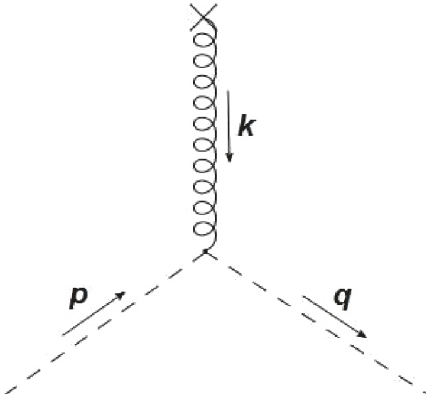
Figure 3: Feynman diagram for the interaction between a spin-0 particle and an external weak gravitational